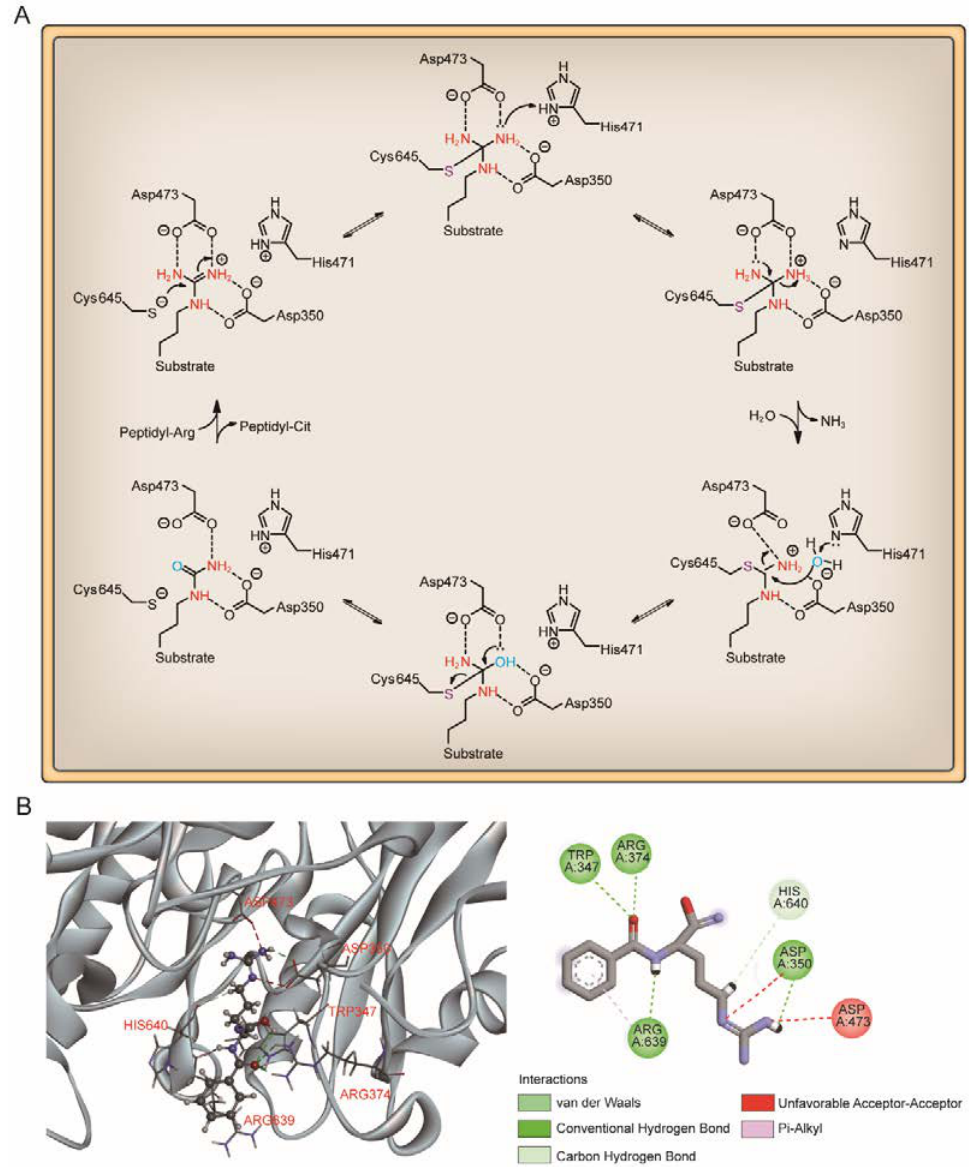
Figure 4. ( A ) Proposed catalytic mechanism of PAD4. ( B ) Interaction between PAD4 and the small- molecule substrate BAA (PDB: 1WDA). BAA is shown in a ball-and-stick model, and protein residues are shown in stick models.